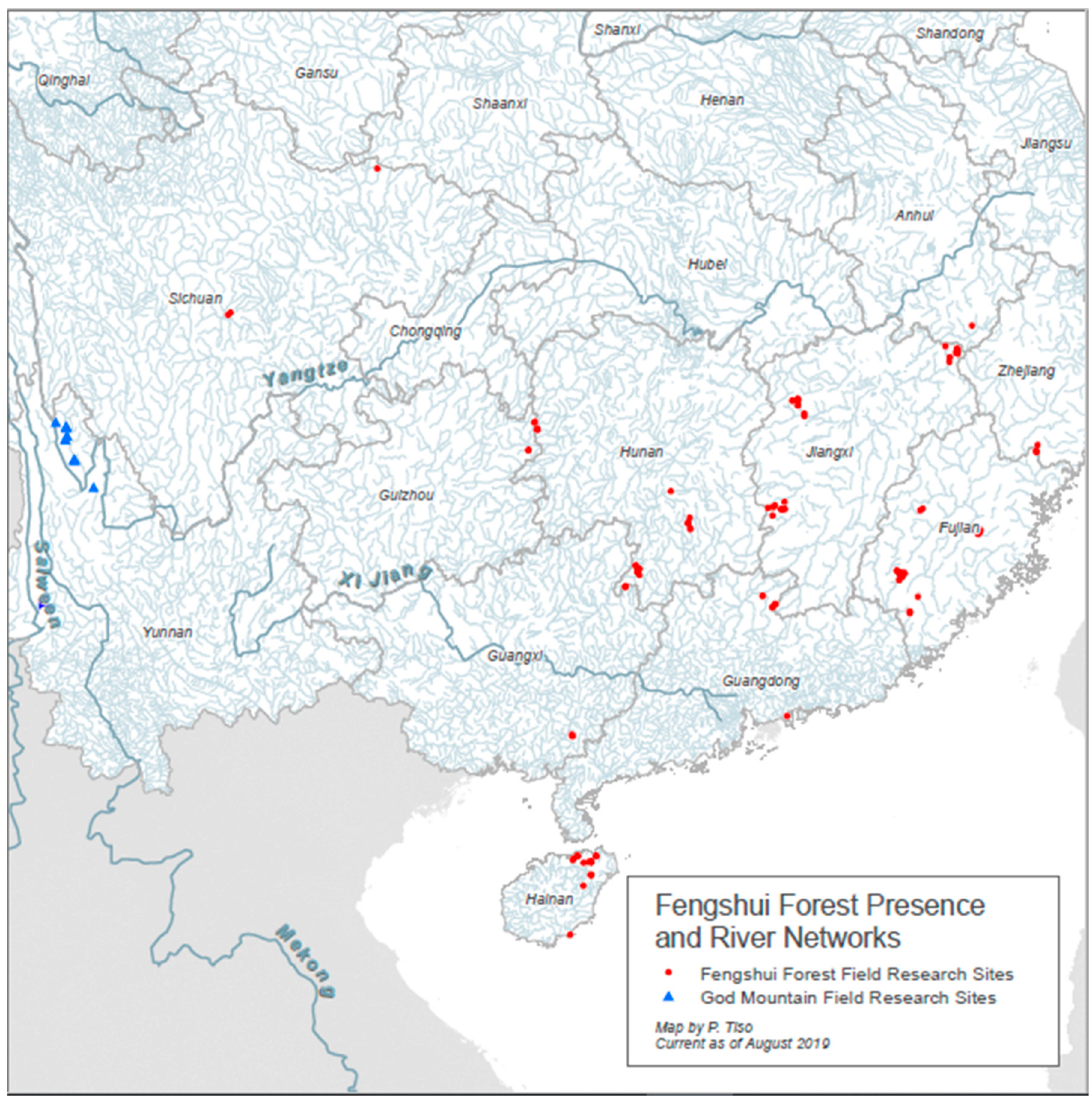
Figure 1. Map of rivers and field sites showing locations of 80 villages in 10 provinces where research on fengshui forests was conducted and 10 villages where research on Tibetan sacred landscapes was conducted.